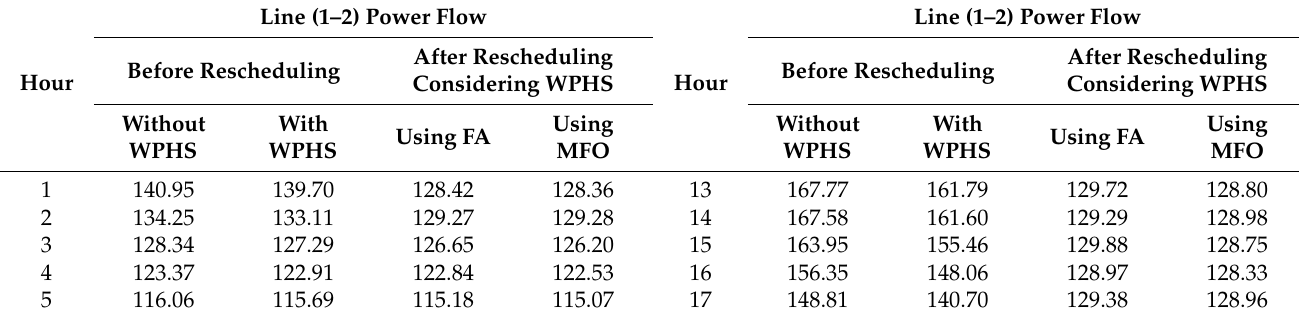
Table 4. Congested line (1–2) power flow before and after rescheduling with and without